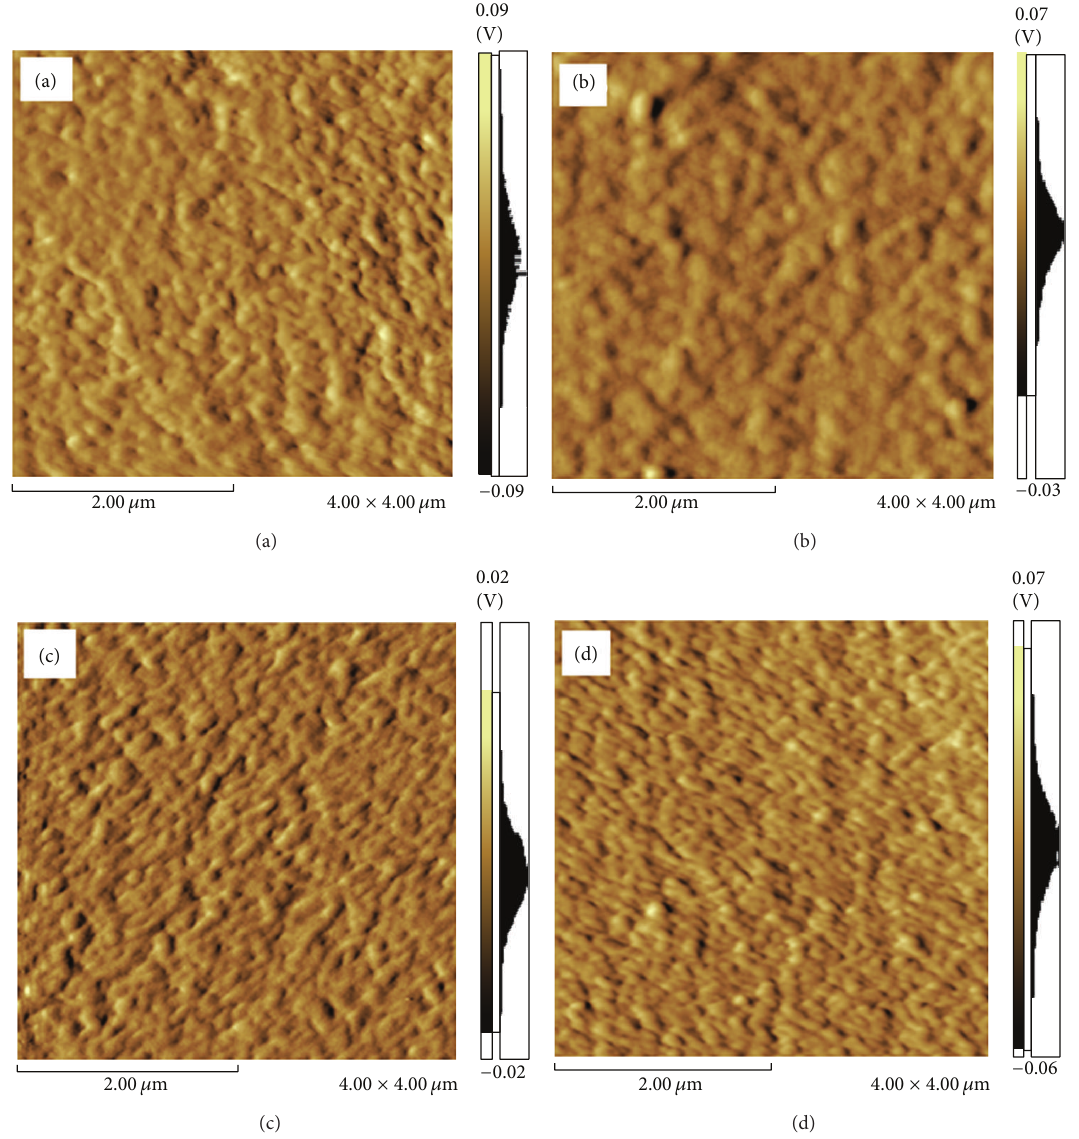
Figure 2: AFM images of regenerated films, (a) AmimCl, (b) BmimCl, (c) EmimCl, and (d) EmimAc.